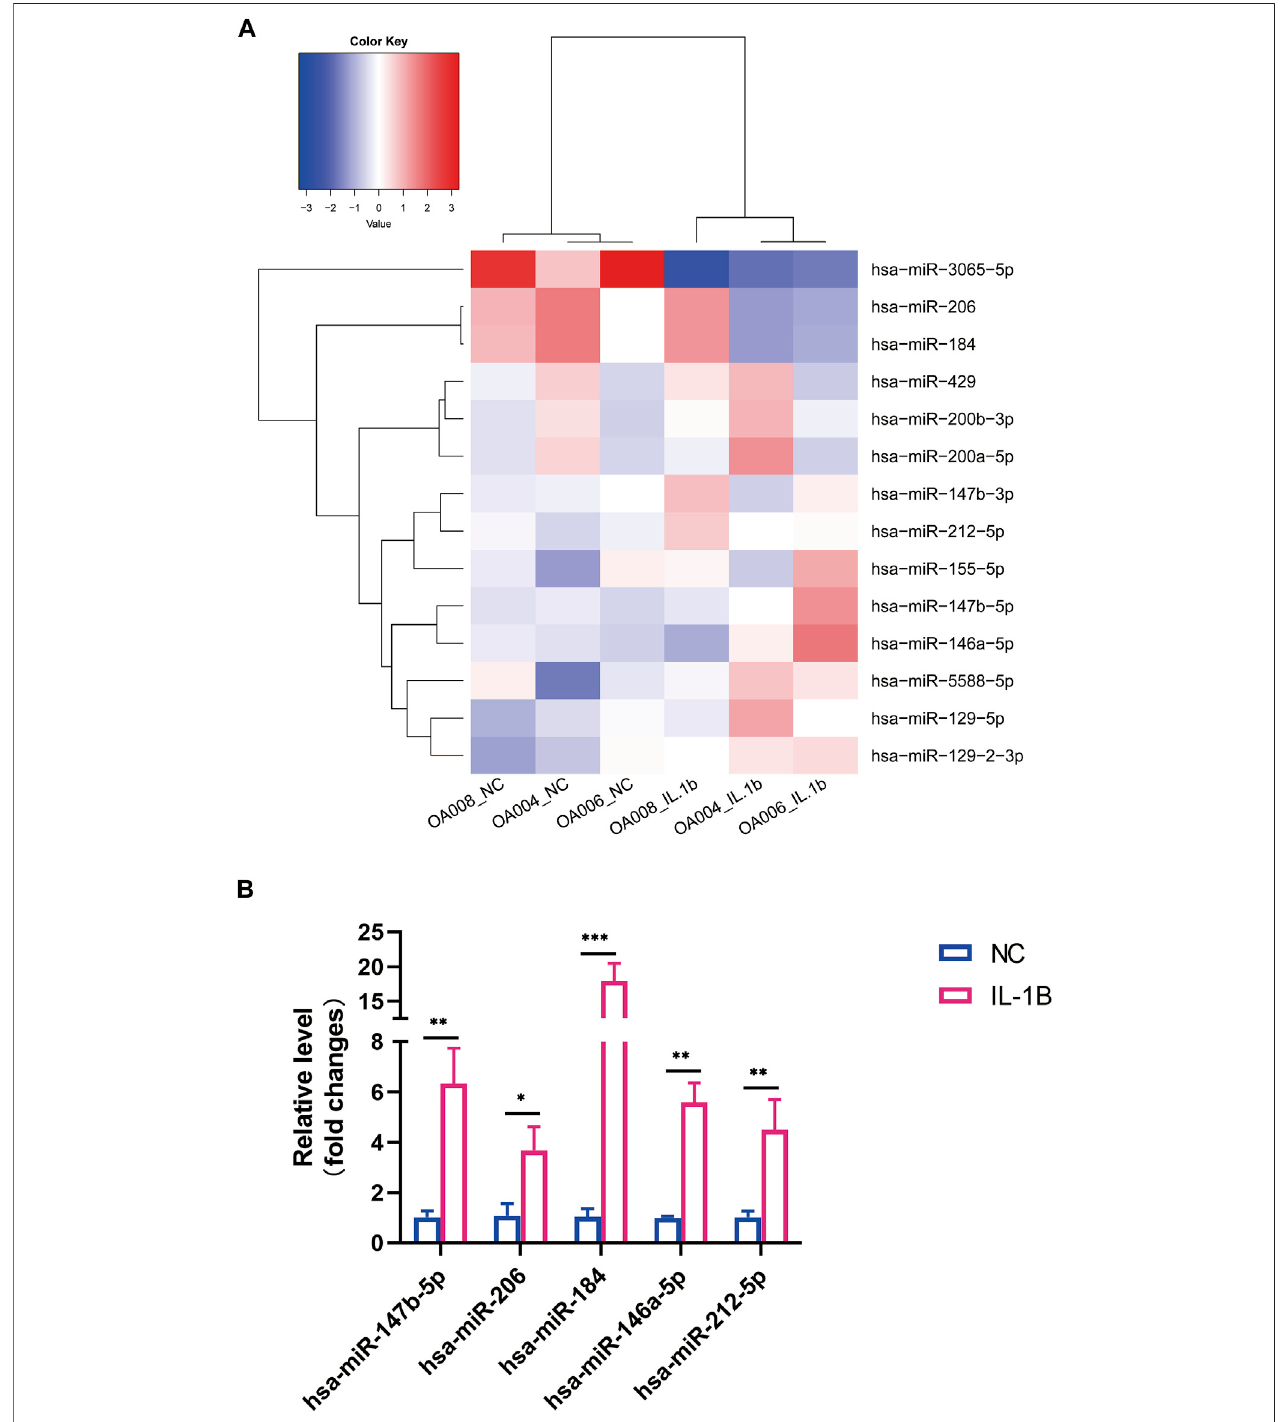
FIGURE 2 | Differential expression pro fi le of microRNA (miRNA) between degenerative menisci with and without IL-1 β stimulation. (A) Hierarchical clustering illustrates distinguished expression difference of miRNA between the two groups and homogeneity between groups. (B) Relative expression level ofselected mRNAs in negative control versus IL-1 β -treated osteoarthritis (OA) menisci. U6 was used as the internal reference gene for qRT-PCR relative expression. Error bars reveal the standard deviation or the standard error of the data. The statistical methods are described above. * p < 0.05, ** p < 0.01, *** p < 0.001.